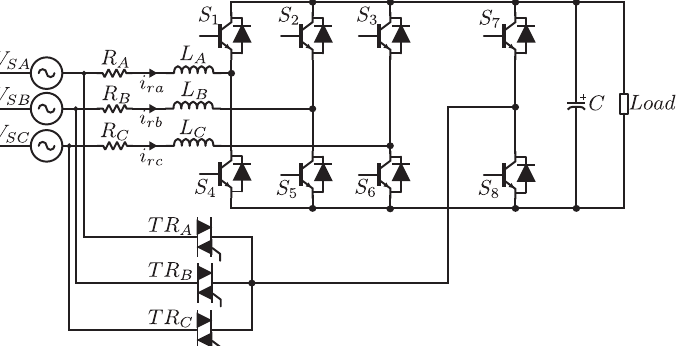
Figure 6. Redundant topology consisting of three extra TRIACs. If a switch fails ( S 1 ,..., S 6 ), the re- spective TRIAC ( TR A , TR B , or TR C ) is